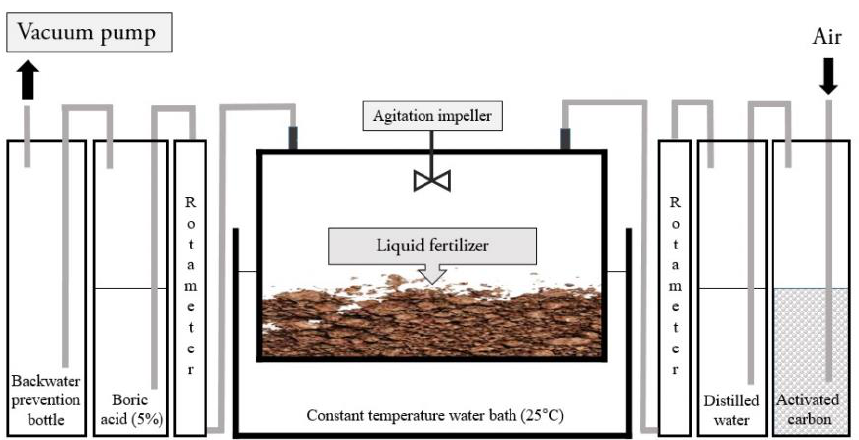
Figure 1. Schematic of a dynamic chamber-capture system with a constant temperature water bath [12].